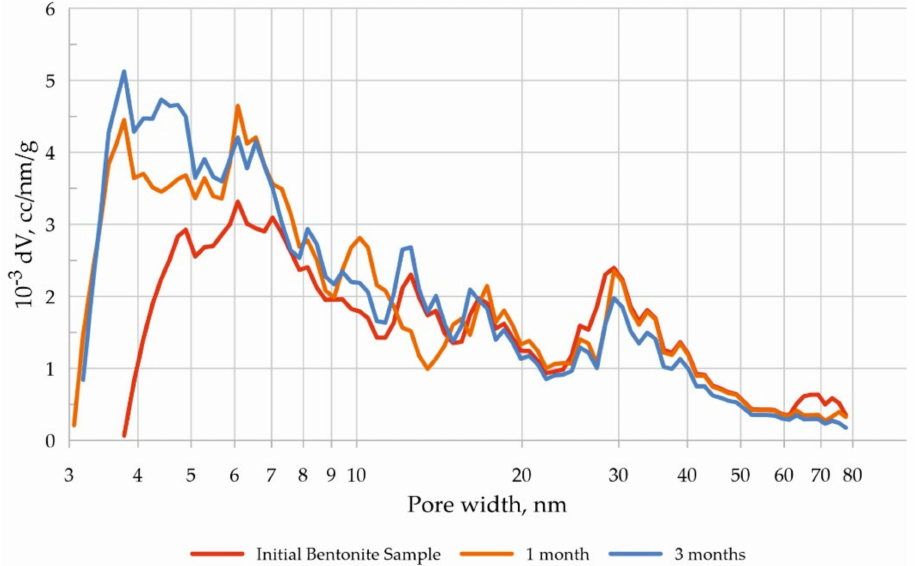
Figure 6. The change in the pore distribution of bentonite as a result of its exposure, for 1 and 3 months, to the synthetic water solution after concrete leaching.